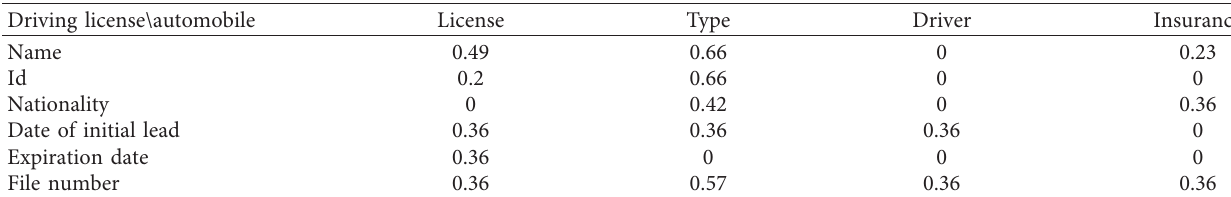
Table 8: Matching between attributes, Set